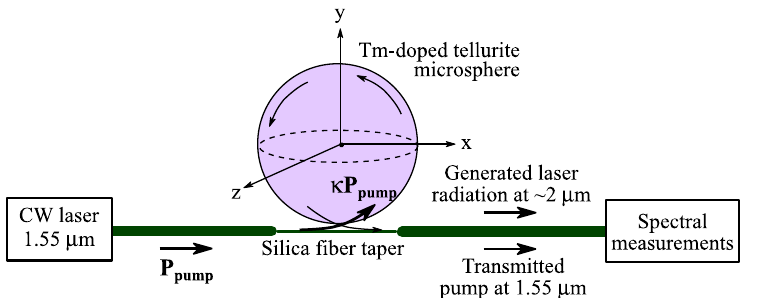
Figure 1. A simplified scheme of the considered system. P pump is a pump power and κ is a coupling